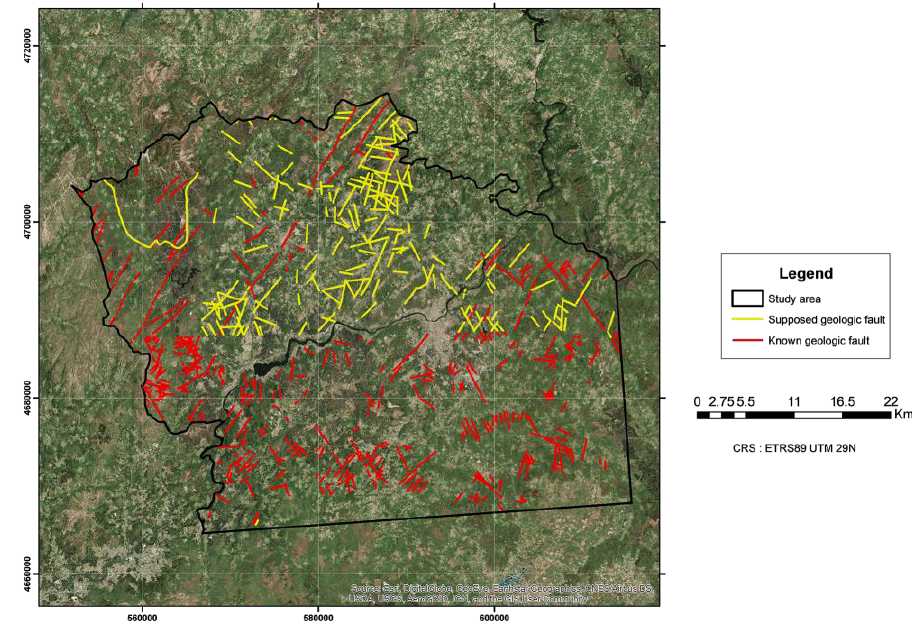
Figure 2. Map of geological faults.